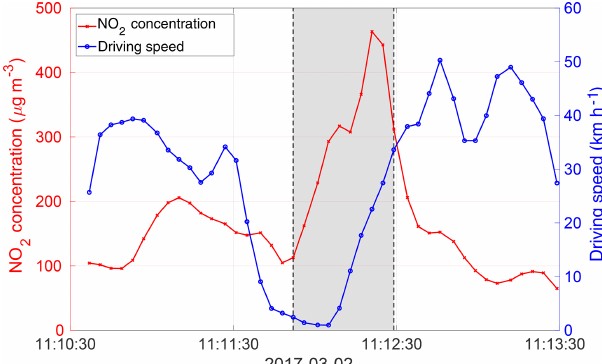
Figure 4. Time series of the driving speed and the coinciding NO 2 concentration during traffic congestion. Data in grey area will be filtered out in a later